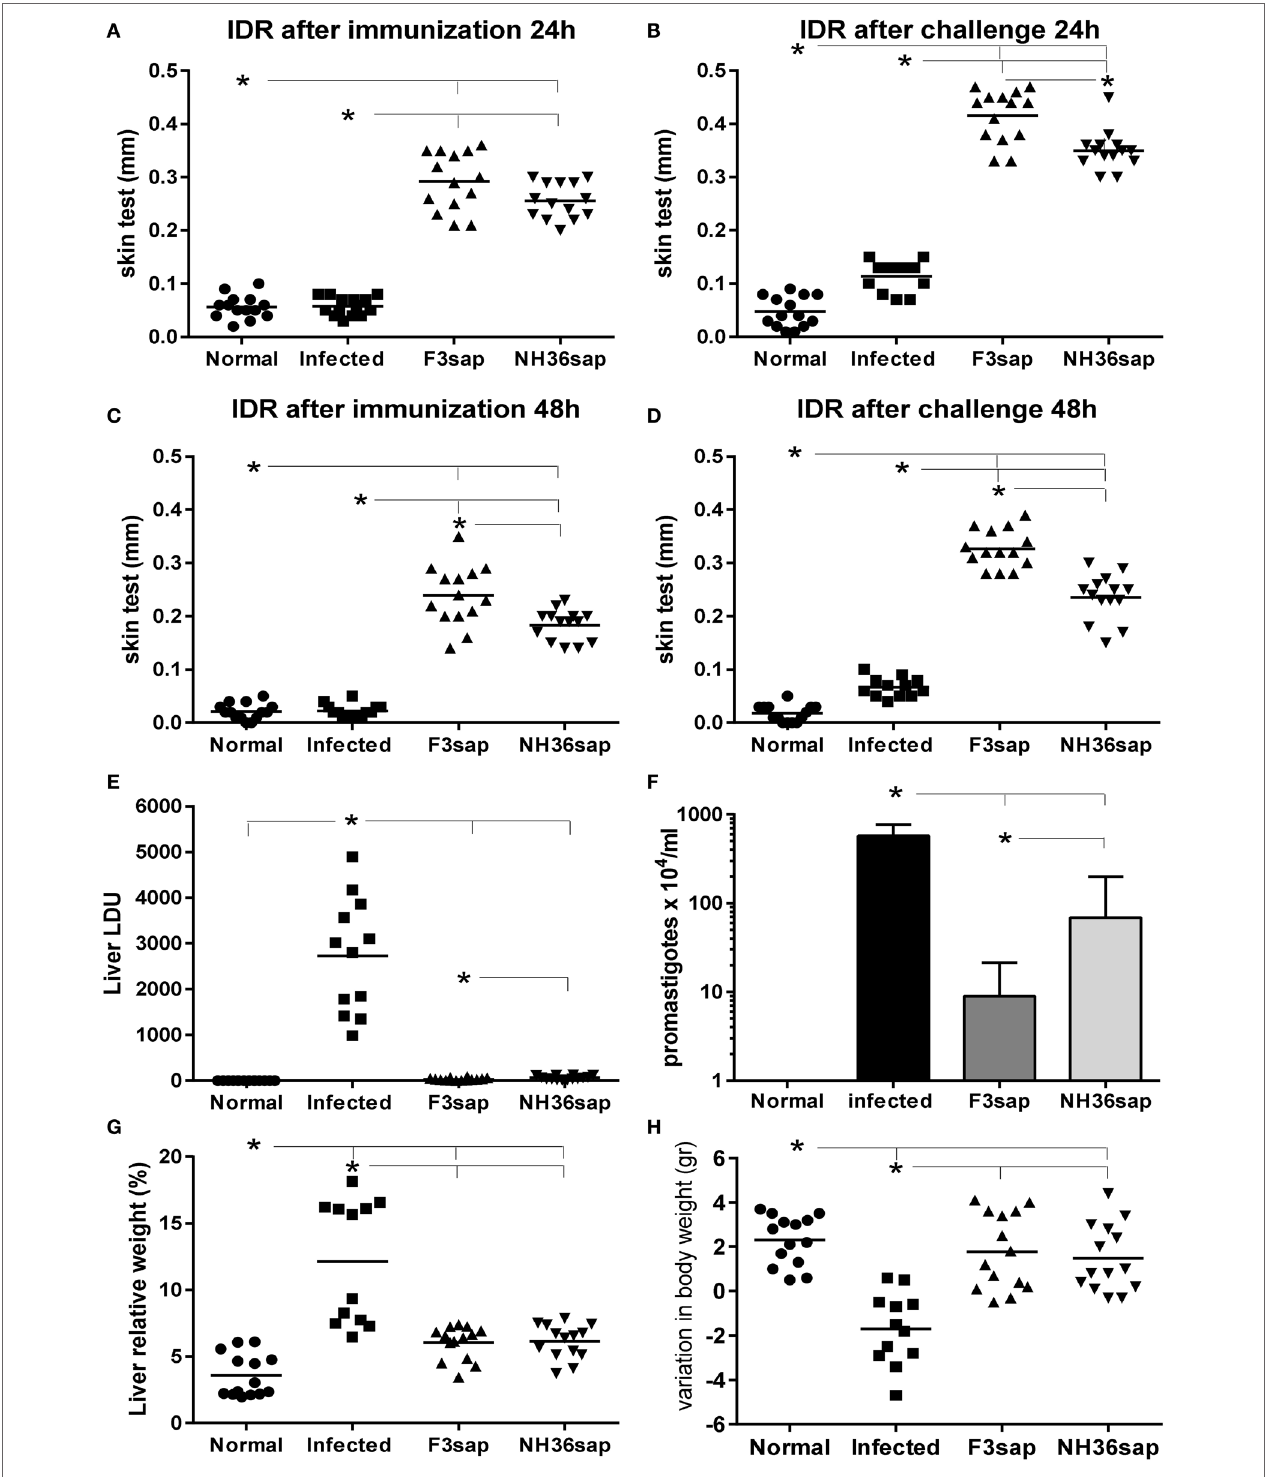
FigUre 1 | F3 and NH36-vaccinated dendritic cells donor mice showed enhanced IDR and reduced clinical and parasitological impact of infection. IDR to the leishmanial antigen was measured at 24 h (a,B) and 48 h (c,D) after complete immunization with the F3 (F3sap) and the NH36 (NH36sap) vaccines, and after immunization and challenge . Parasite load in liver is expressed as LDU values (e) and total promastigotes/ml, in in vitro cultures of livers as determined by the limiting dilution assay method (F) . Liver relative weight (g) , and gain in corporal weight in grams (h) were recorded after euthanasia. Results represent the individual values of two-independent experiments ( n = 6–7 C57BL/6 mice per treatment for each experiment). Horizontal full lines represent the mean values. Asterisks and horizontal lines show significant differences between treatments as disclosed by Mann–Whitney non-parametrical